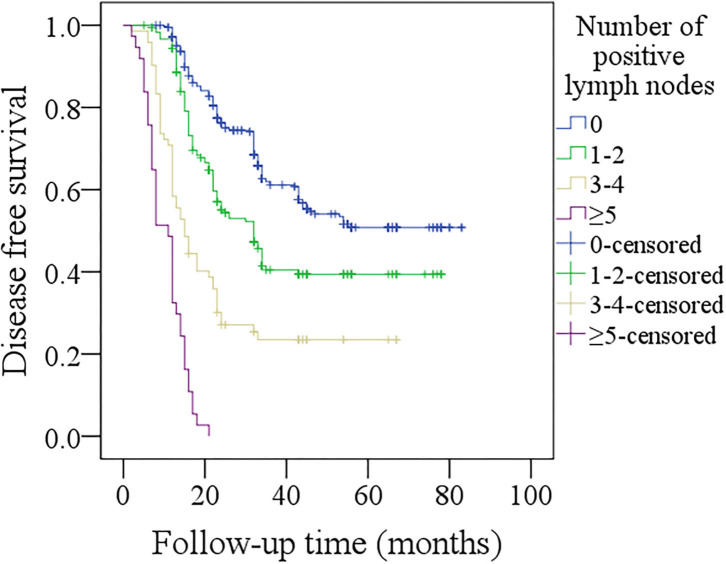
Comparison of disease-free survival among patients with different numbers of positive lymph nodes (p < 0.001).